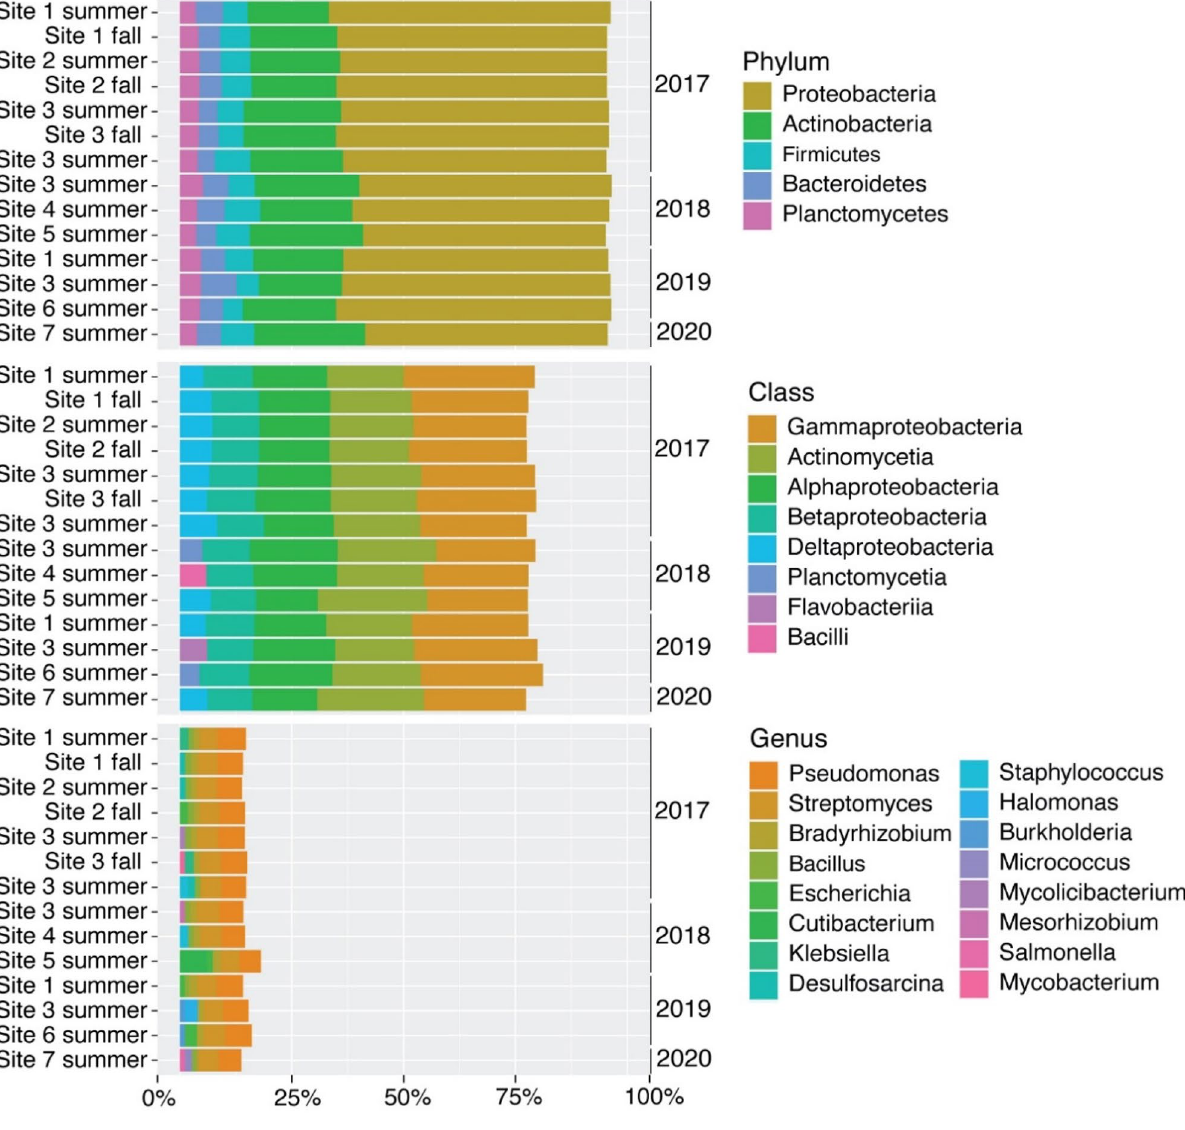
Figure 2. Stacked bar plots showing relative abundance for the top five groups at each sample site and at each taxonomic level: phylum, class, and